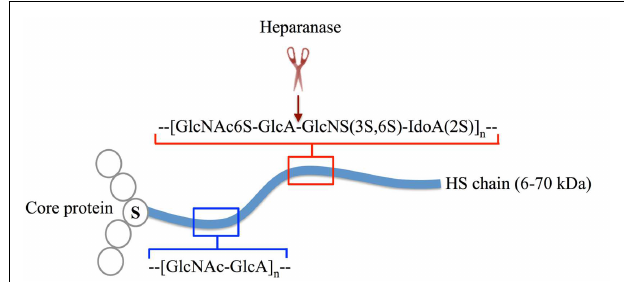
FIGURE 1 |The structure of HSPG . HS chains (blue line) are linear polysaccharides composed of repeating disaccharide subunits, which in their unmodified form are D -glucosamine and D -glucuronic acid (blue box). During synthesis, HS chains are covalently attached to core proteins (open circles) at serine (S) residues. A single HSPG molecule may carry multiple HS chains or contain other glycosaminoglycans other than HS (not shown). HS modifications include various degrees of O and N-sulfation and epimerization of D -glucuronic acid to D -iduronic acid by HS-modifying enzymes (red box) (1).The modifications occur in regions (hot spots) along the polysaccharide chain, these hot spots being separated by regions of low sulfation. Post-synthesis structural alterations are primarily mediated by the endo- β -glucuronidase, heparanase, which cleaves HS chains within highly sulfated regions (cleavage site indicated by red scissors and arrow) (3).